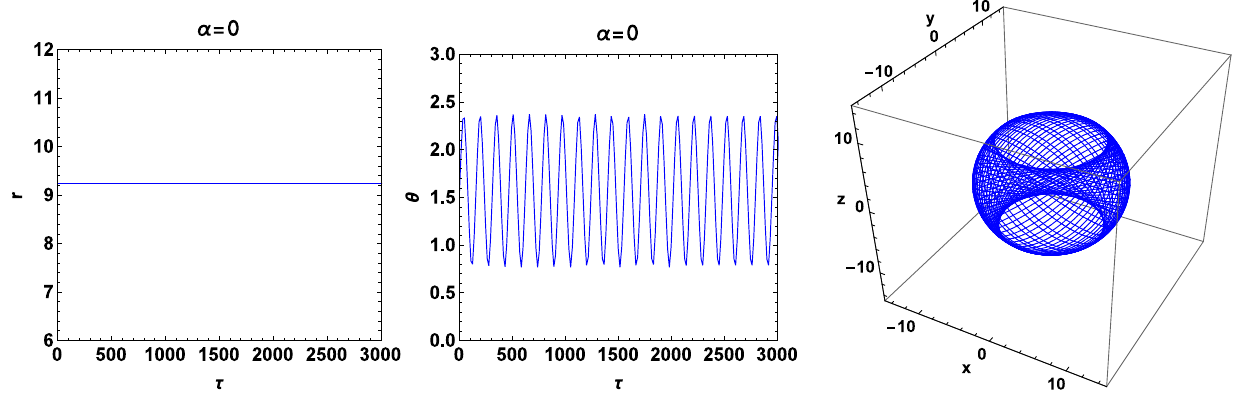
Fig. 3 The chosen periodic orbit of the scalar particle in a Kerr black hole spacetime with E = 0 . 95, L = 2 . 4 M , a = 0 . 8 and α = 0